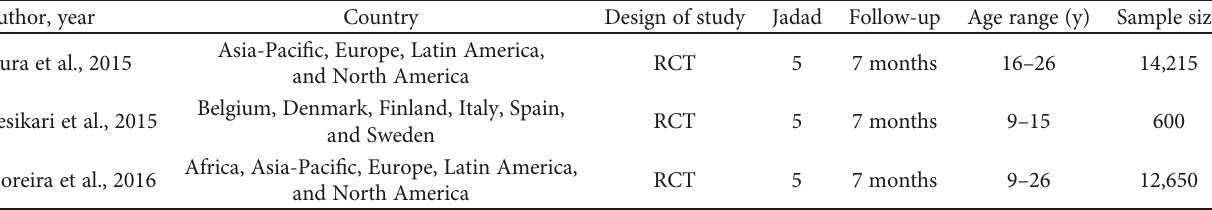
Table 1: Description of the characteristics of included